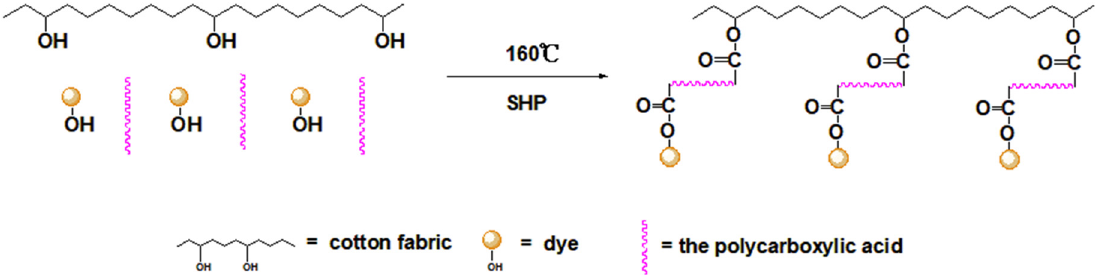
Figure 3. Schematic diagram of the polycarboxylic acid cross-linking process.